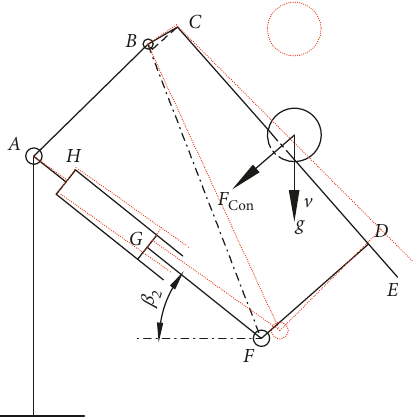
Figure 9: Dynamic model of the system.